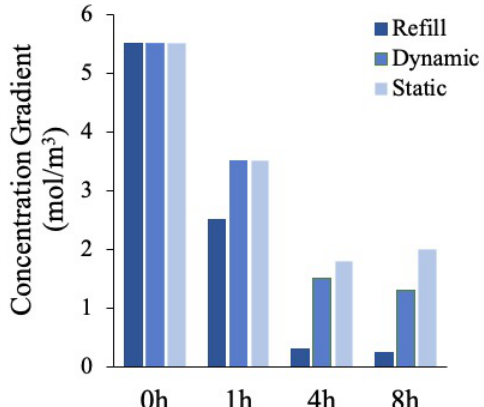
Figure 6. Glucose concentration gradients values in the three culture scenarios considered at different time points: t 0 = 0 h, t 1 = 1 h, t 2 = 4 h, t 3 = 8 h.